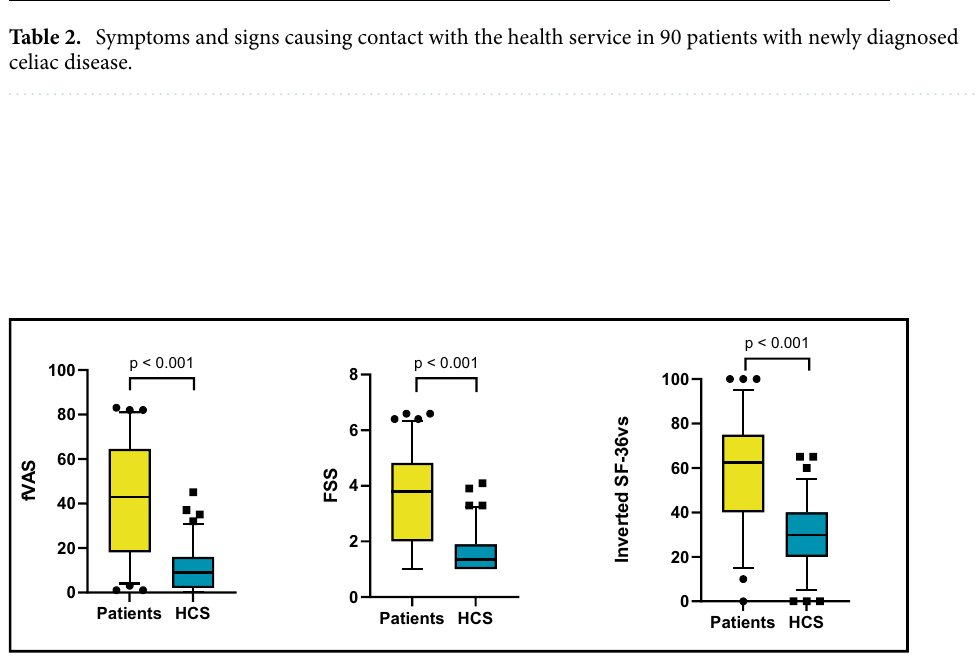
Figure 2. Fatigue measures using three different instruments in 90 patients with celiac disease and 90 healthy age- and sex-matched subjects. Box plots indicate median (line), interquartile range (box), and 5th to 95th percentiles (whiskers); dots represent outliers. To the right in the figure SF-36vs scores are inverted to ease visual interpretation. fVAS Fatigue visual analog scale, FSS Fatigue severity scale, SF-36vs Vitality subscale of the MOS 36-item short-form health survey, HCS Healthy control